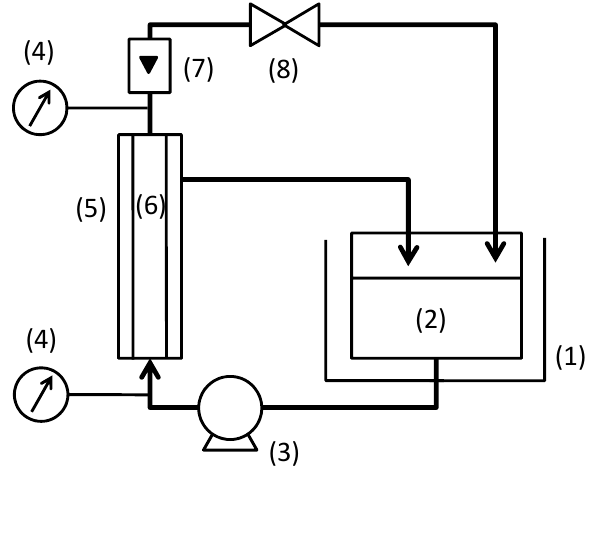
Figure 1. Experimental set-up for cross-flow filtration: (1) thermostatic bath; (2) feed tank; (3) pump; (4) pressure gauge; (5) membrane module; (6) ceramic membrane; (7) flow meter; (8)